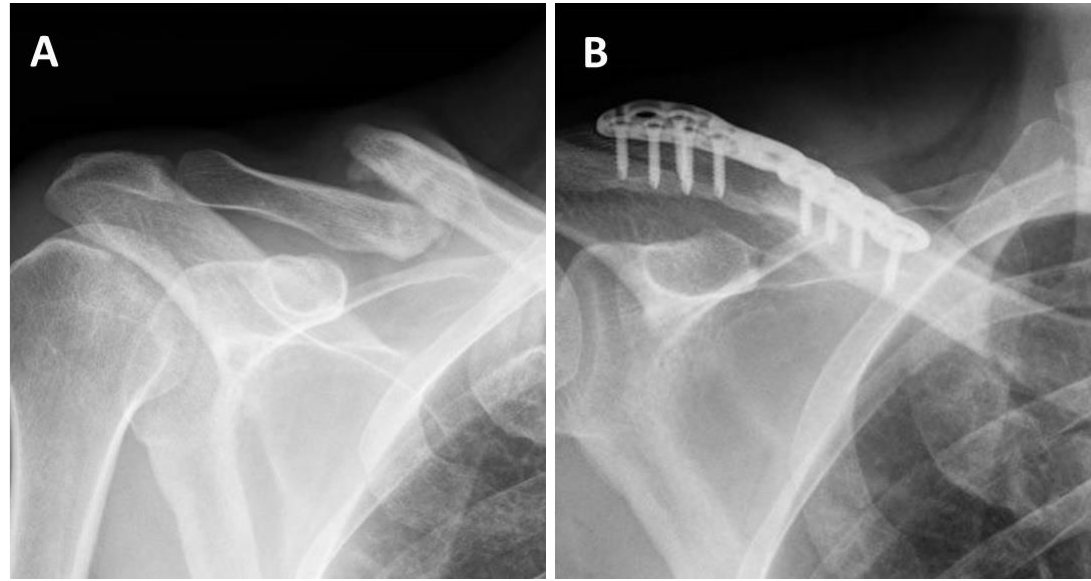
Figure 1. A 47 year old patient who suffered from symptomatic right–middle clavicle nonunion after conservative treatment: preoperative X-ray ( A ) at 5 months after the injury, and ( B ) at 1 year following ORIF with supplementation of BMAC. ORIF; open reduction and internal fixation BMAC; bone marrow aspirate concentrate.